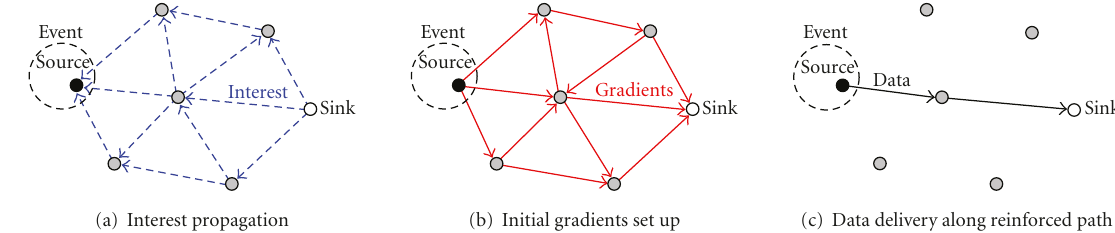
Figure 1: Simplified schematic of directed di ff